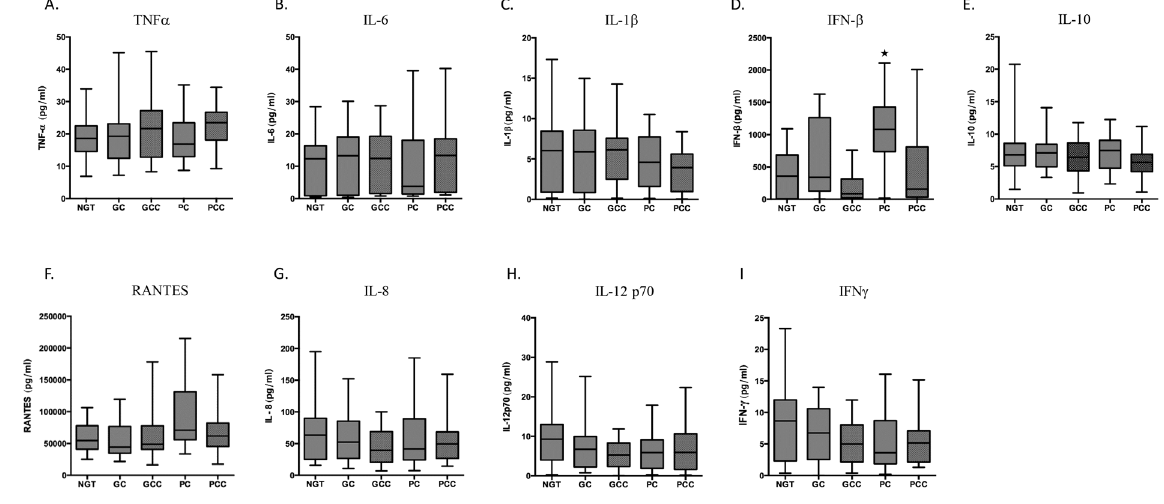
Figure 1. Levels of cytokines in sera from NGT and T2DM patients. TNF- α ( A ), IL-6 ( B ), IL-1 β ( C ), IFN- β ( D ), IL-10 ( E ), Rantes ( F ), IL-8 (G) IL-12 ( H ) and IFN γ (I ) levels in NGT (n = 34), GC (n = 27), GCC (n = 32), PC (n = 21) and PCC (n = 32) patient groups. * p < 0.05, ** p < 0.01, *** p < 0.001 vs. NGT.